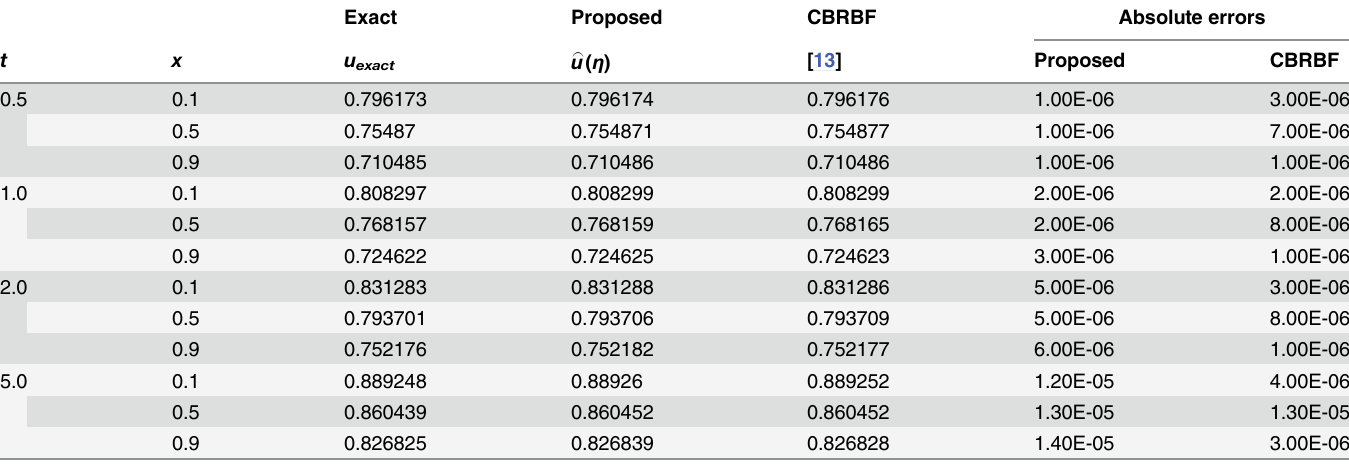
Table 13. Numerical solutions of generalized Burgers 0 equation by the proposed scheme and comparison with exact solutions, and CBRBF [13] for α = 1, β = 0, and δ = 3. Exact Proposed CBRBF Absolute errors